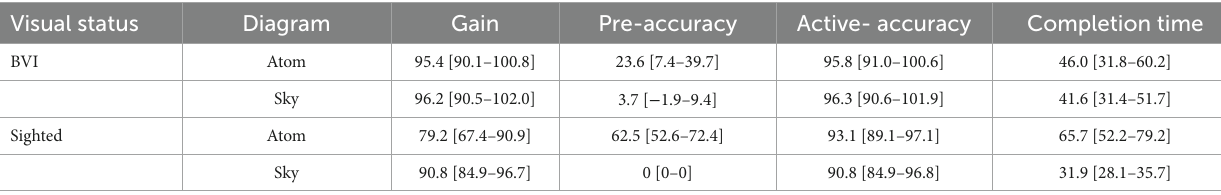
TABLE 7 Summary of pre/post accuracy collapsed across mode. Visual